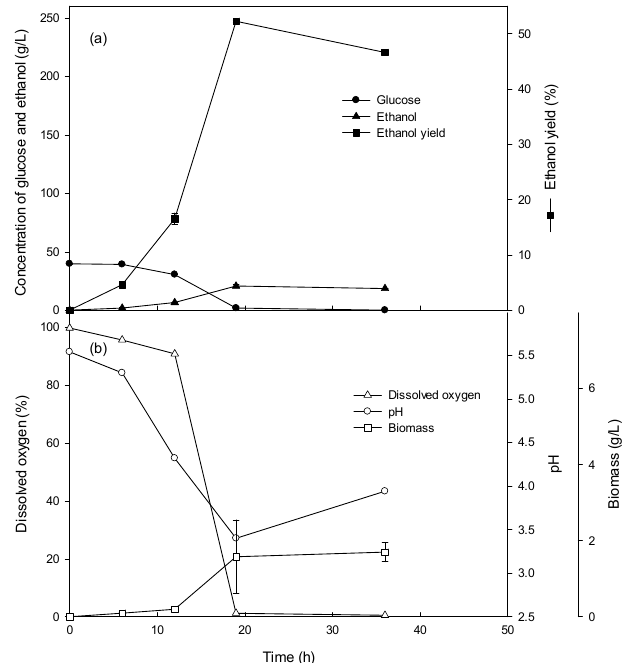
Figure 1. Time course of ( a ) glucose, ethanol concentration, and ethanol yield change, ( b ) dissolved oxygen, pH, and biomass in the batch cultures of S. cerevisiae BCRC 21812. The initial glucose concentration was 4% ( w / v ).